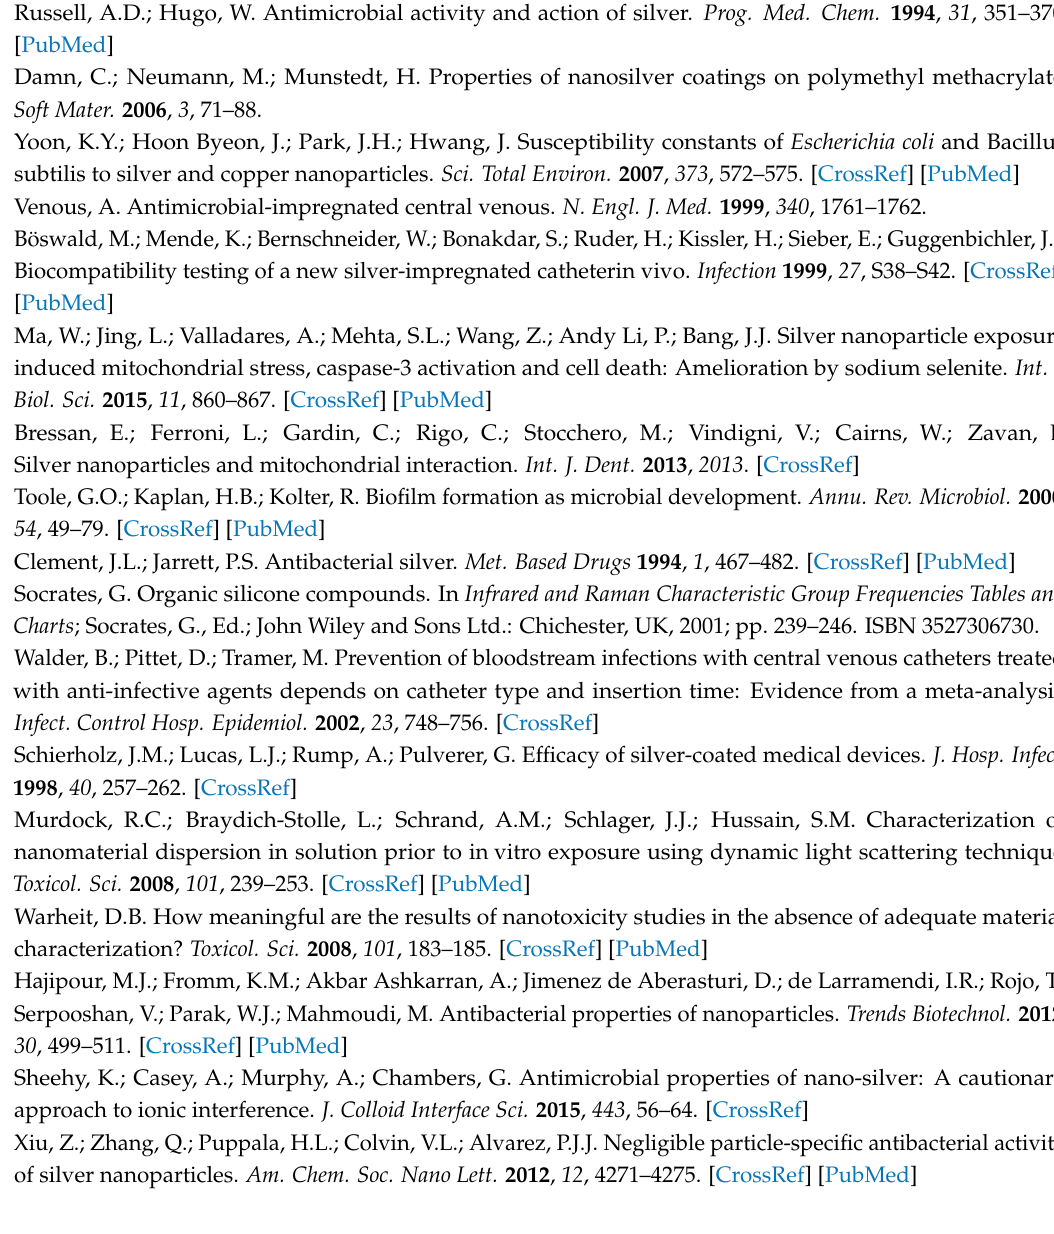
Figure S1: Serratia marcescens; Figure S2: Escherichia coli ; Figure S3: Bacillus subtilis ; Figure S4: Bacillus megaterium ; Figure S5: Aspergillus niger ; Figure S6: Trichoderma virdi ; Figure S7: Cladosporium cladosporioides ; Figure S8: Chaetomium globosum ; Figure S9: Mortierella alpine